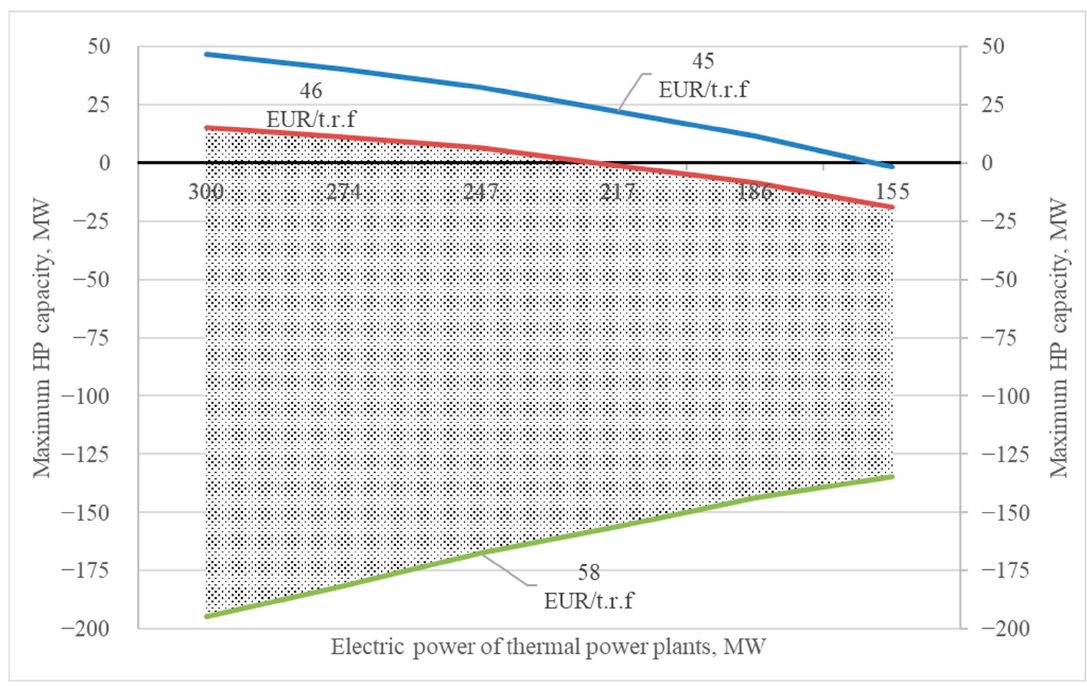
Figure 12. Maximum HP capacity with a TPP with steam turbine type К -300-170-1 Р .